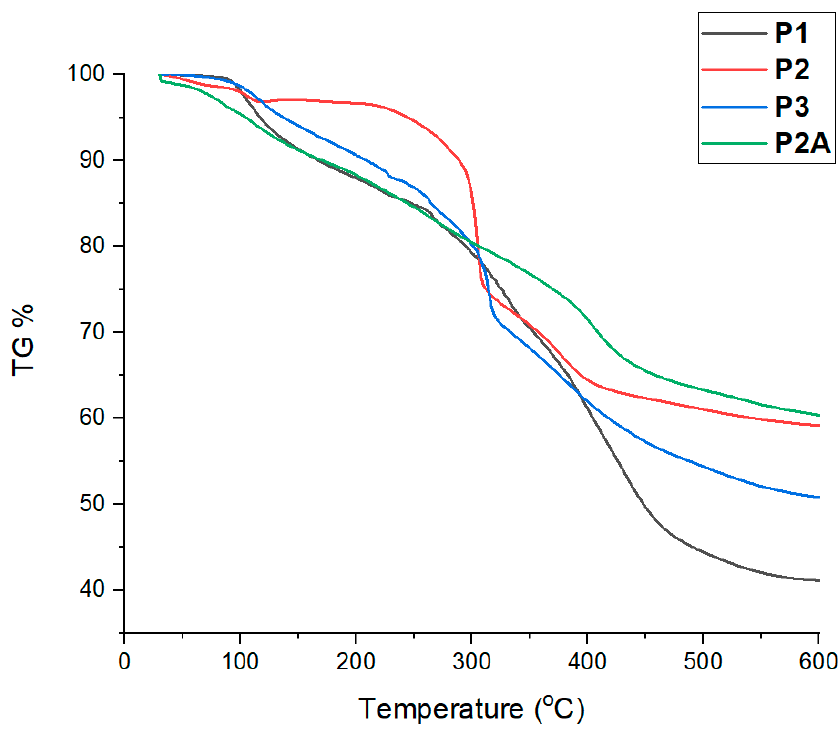
Figure 3. Thermal gravimetric analysis of phosphonate ester- or phosphoric acid- and carborane-bearing block copolymers under nitrogen atmosphere. Polymers 2019 , 11 , 613